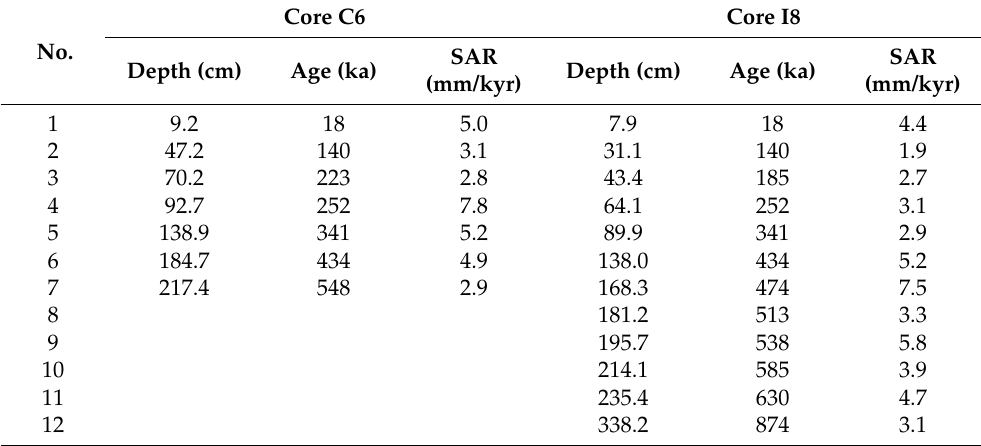
Table 1. Age models of the two studied